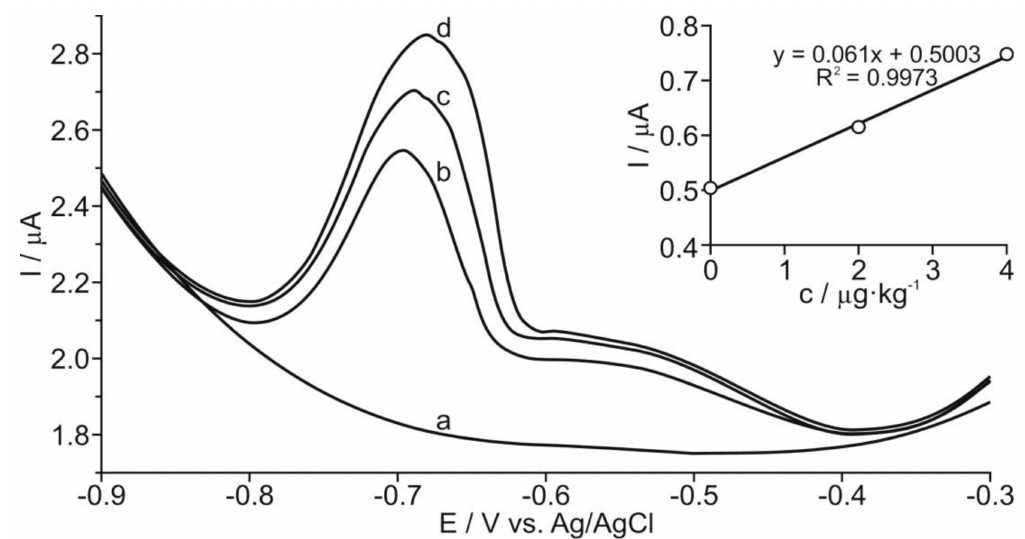
Figure 5. Voltammogram of the processed grain product sample ( b ) together with voltammograms of the sample with the sequential standard addition of ( c ) 2 ppb Tl and ( d ) 4 ppb Tl, as well as the calibration graph. ( a ) The base electrolyte: 0.05 M EDTA (pH = 4.5). Pre-concentration potential: − 1.2 V vs. Ag/AgCl pre-concentration time: 600